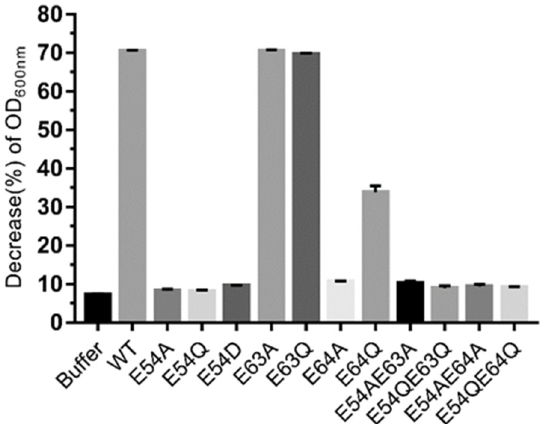
Figure 5. Lytic activity of endolysin LysO78 and its mutants. The antimicrobial activity assay was performed using the WT endolysin LysO78 and various mutant enzymes. Absorbance at 600 nm was measured using E. coli APEC O78 as a substrate. Measurements were performed in triplicate for each sample and error bars were calculated from these measurements. The decrease (%) in optical density at 600 nm (OD600) = (1 − absorbance of the bacterial suspension at the end of each treatment/absorbance at the beginning of each treatment) × 100%.